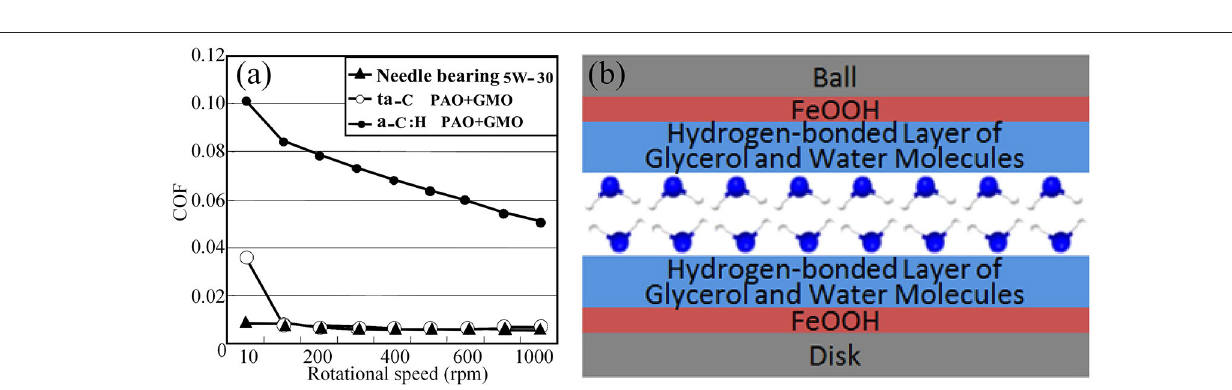
the COF of a hydrogen-containing DLC/steel tribopair is >